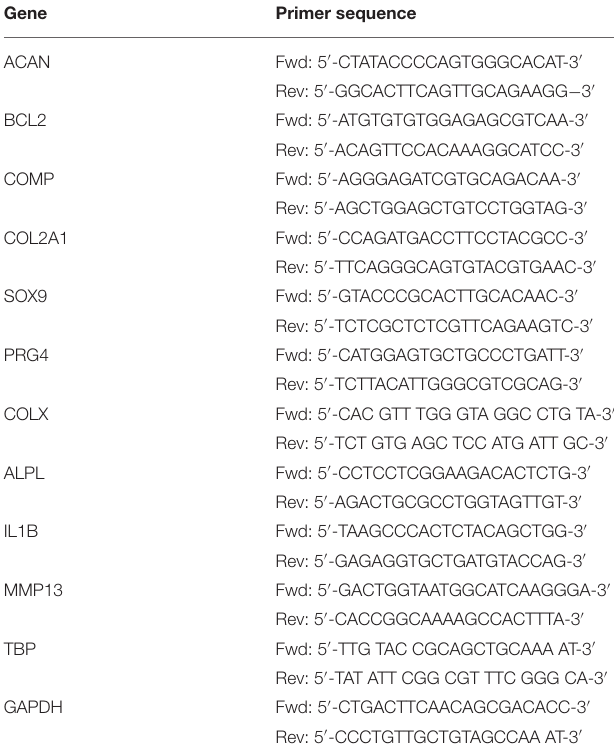
TABLE 1 | Primer sequences for qPCR.